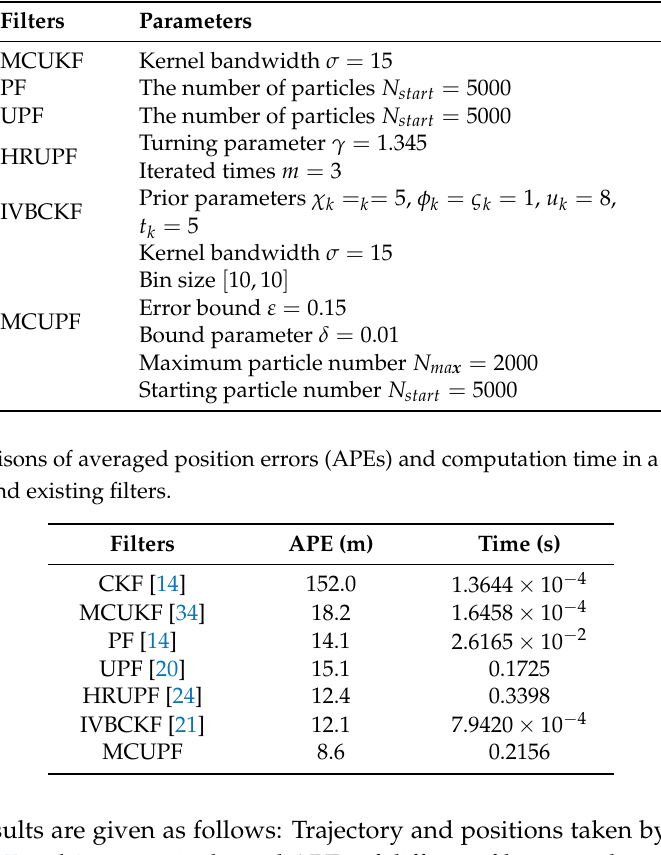
Table 6. Parameters of employed filters.